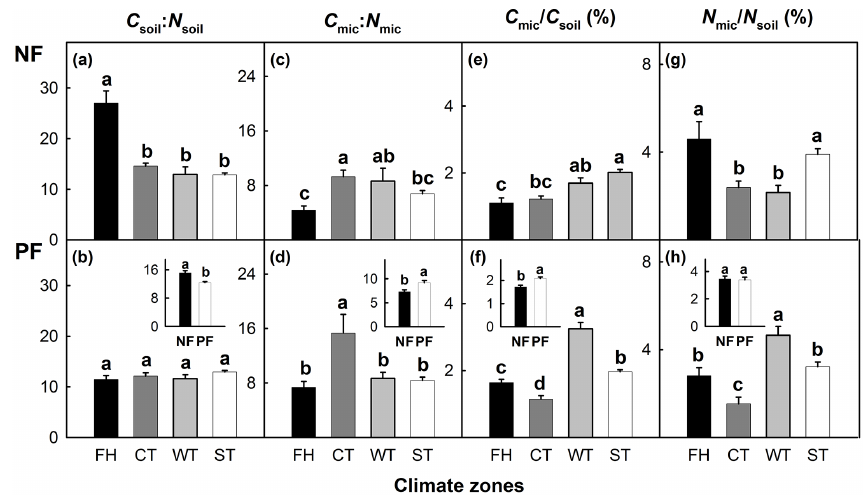
Figure 5. Comparisons of C soil :N soil ratio (a, b) , C mic :N mic ratio (c, d) , C mic / C soil rate (e, f) , and N mic / N soil rate (g, h) among climate zones and between management regimes. Inserted figures are overall comparisons between the natural (NF) and planted forests (PF). C soil , N soil , C mic , and N mic stand for soil organic carbon, soil total nitrogen, microbial biomass carbon, and microbial biomass nitrogen, respectively. FH, CT, WT, and ST stand for frigid highland zone, cool temperate zone, warm temperate zone, and subtropical / tropical zone, respectively. Different lowercase letters denote significant differences among climate zones or between management regimes (mean ± SE , α =